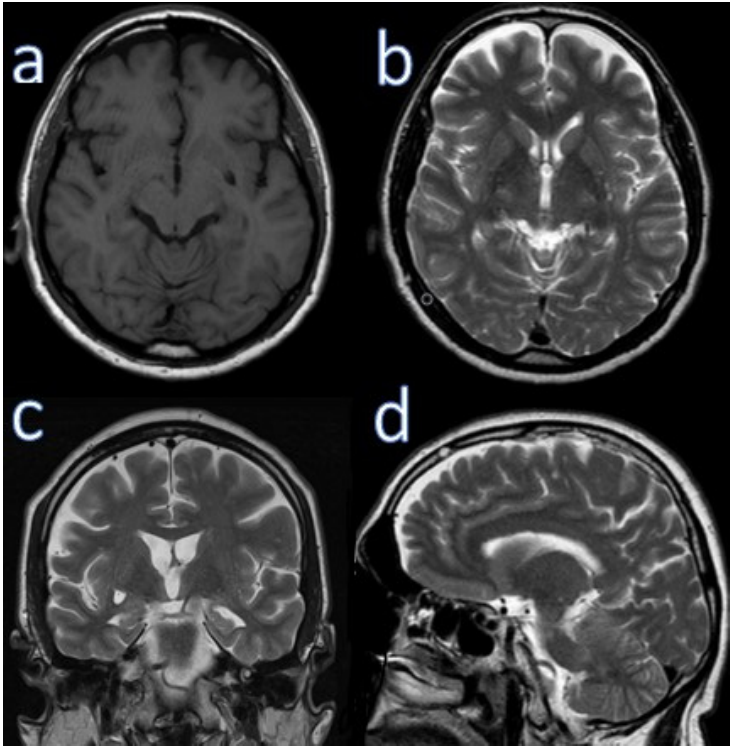
Figure 2. Brain MRI of case 2. ( a ) Axial T1 weighted, ( b ) axial T2 weighted (upper row). ( c ) Coronal T2 weighted, ( d ) sagittal T2 weighted (lower row). T2 weighted, ( d ) sagittal T2 weighted (lower